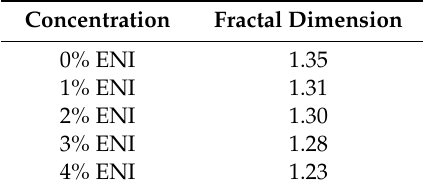
Table 3. Fractal dimension with di ff erent enhanced normality ionic (ENI) concentrations.